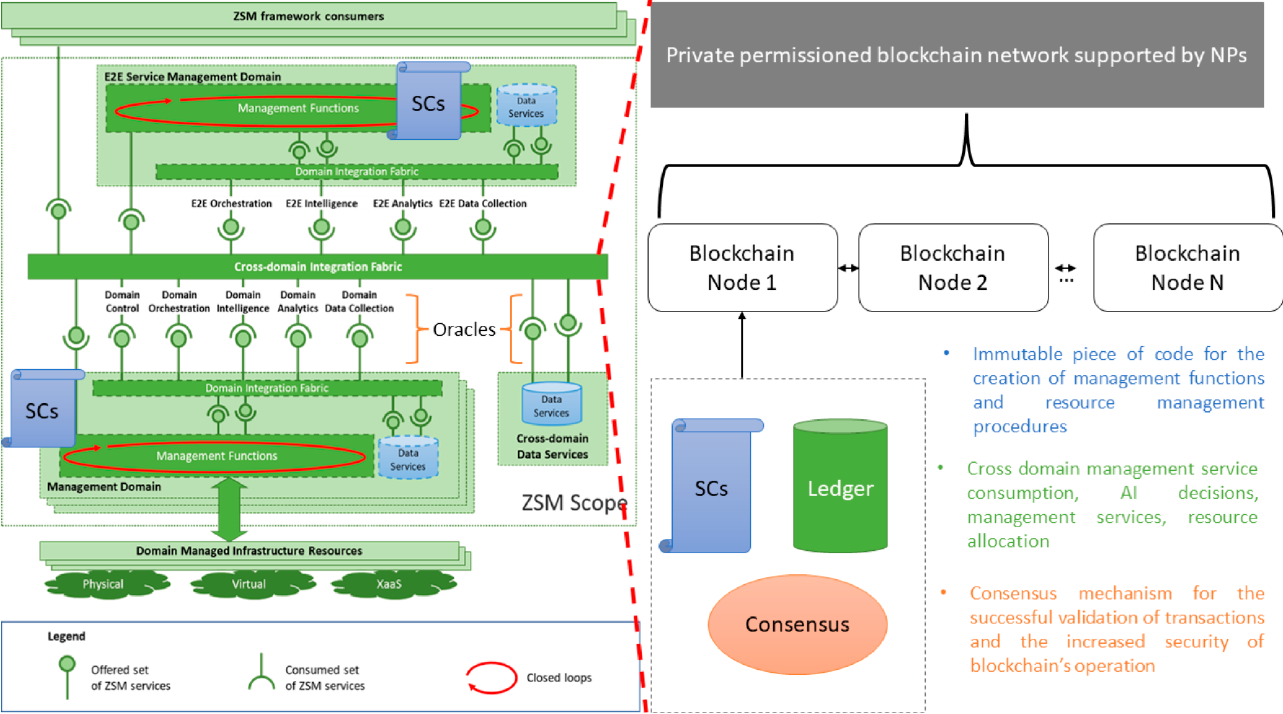
Figure 2. The architecture of blockchain-based ZSM.